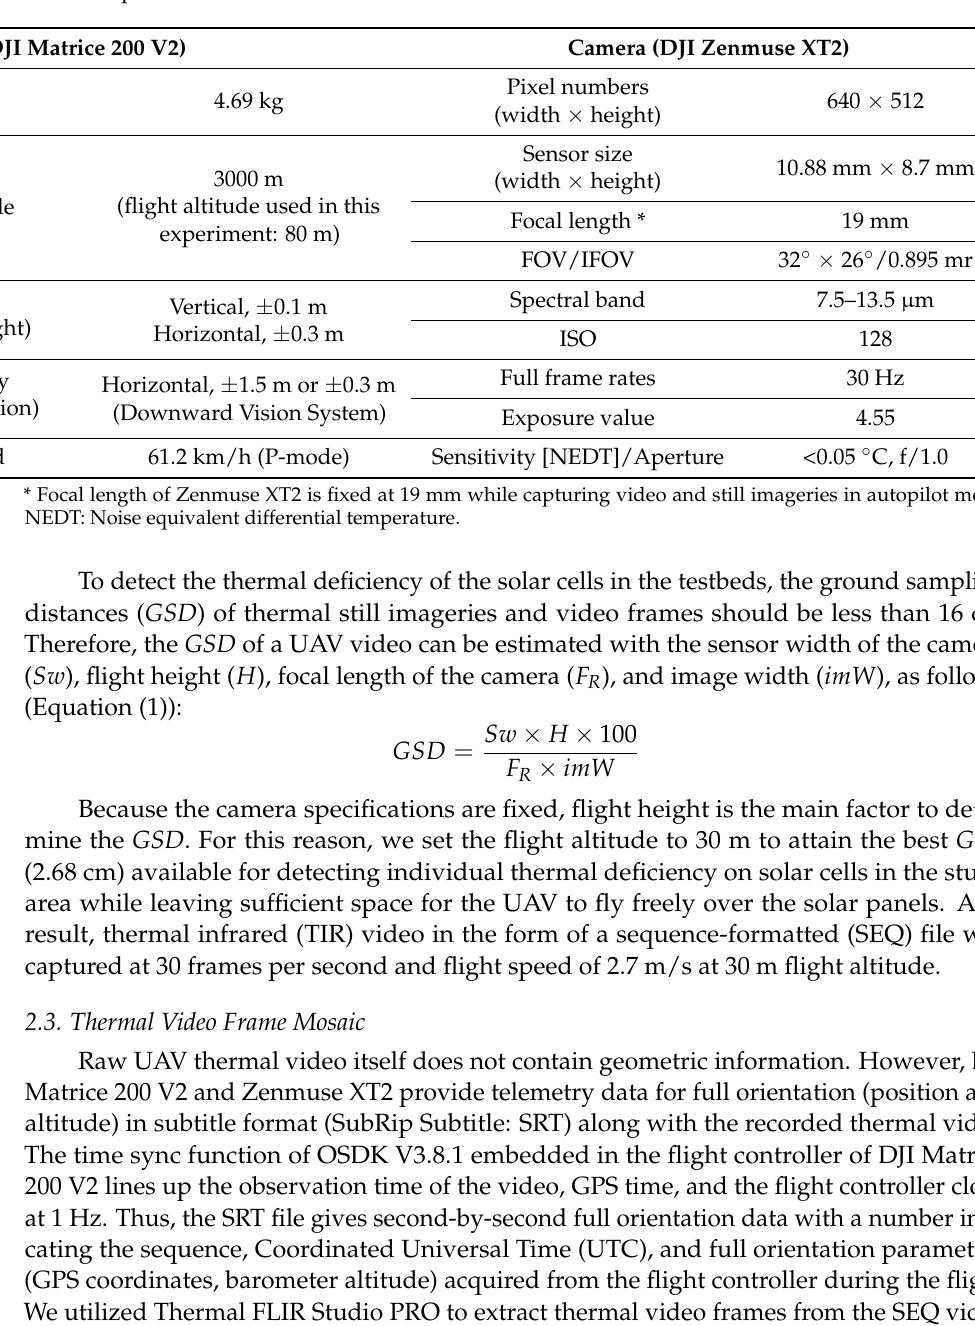
Table 1. Specifications of UAV and thermal